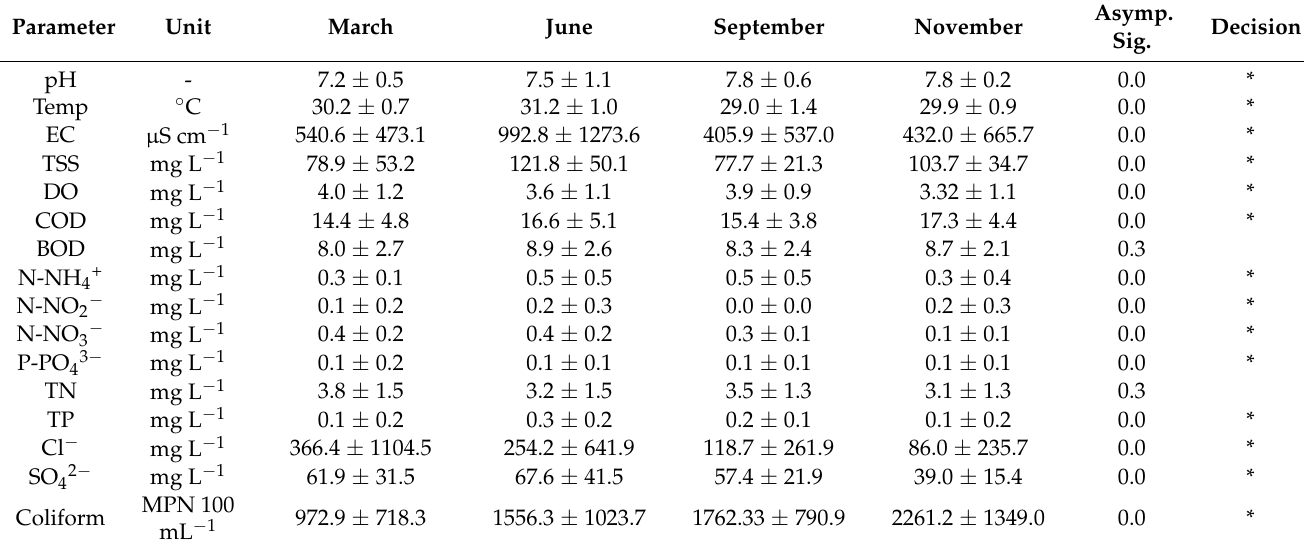
Table 1. Characteristics of surface water in Tien Giang Province in